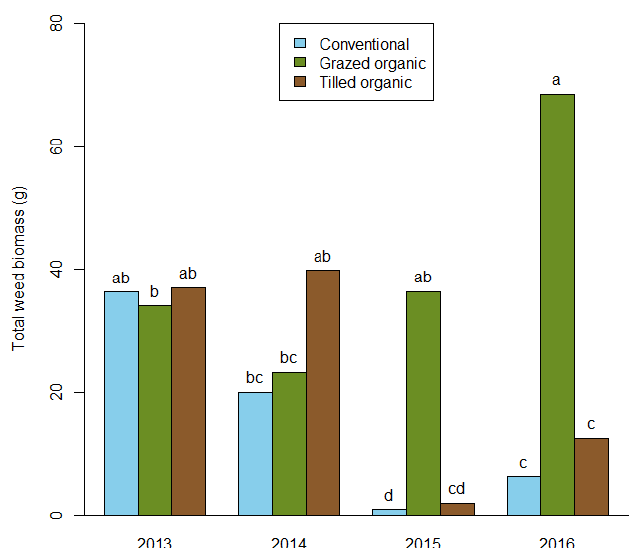
Figure 2. Yields of ( A ) winter wheat yield following sweet clover and ( B ) lentil yield from three cropping systems at Bozeman, MT, USA, 2015–2016. Bars marked with the same letters do not differ at p < 0.1 within year.